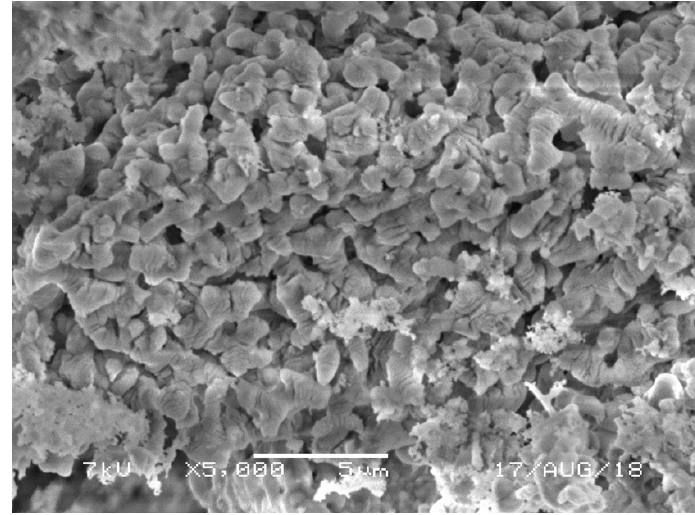
Figure 12. SEM of pure wood-ash sample.